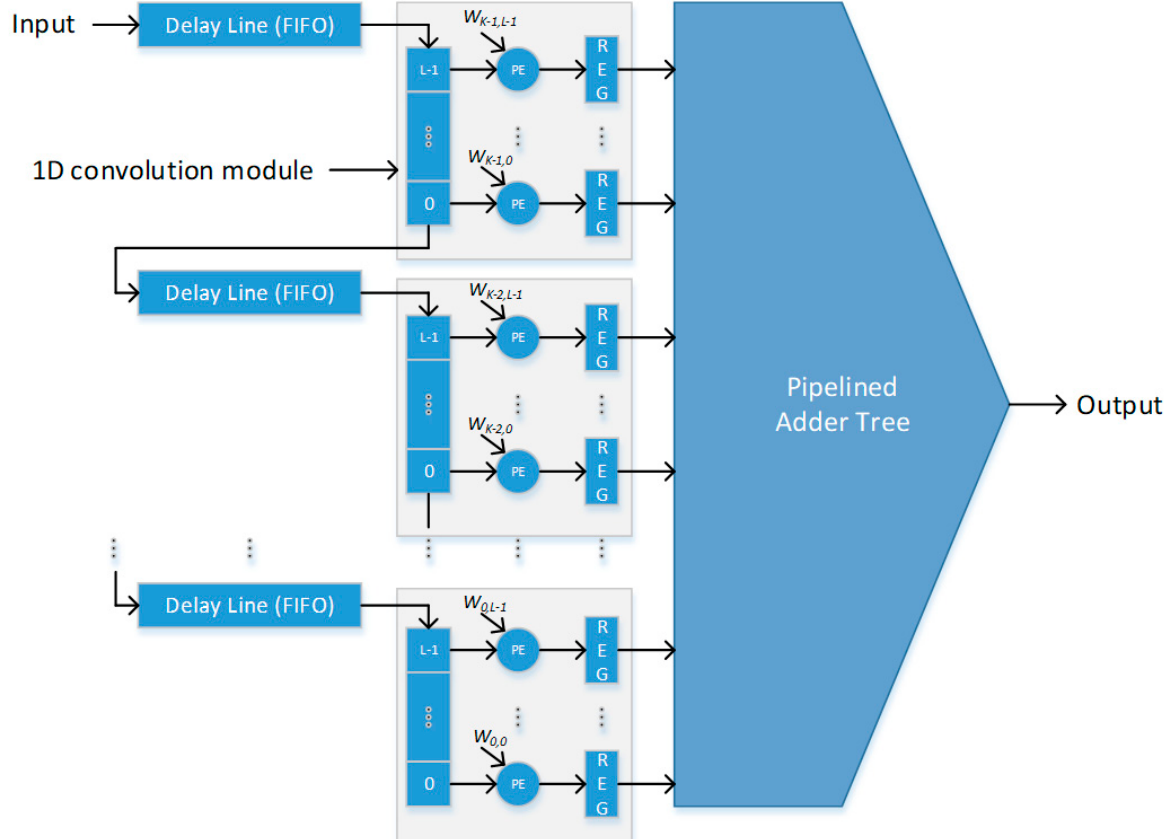
Figure 9. Parallel architecture design for a 2D convolution module.